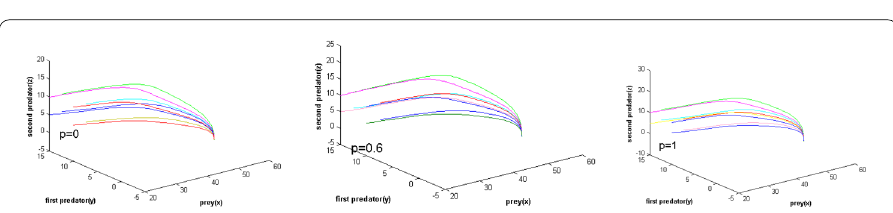
Figure 5 The model system (3.4) reaches the stable axial equilibrium point e 1 ( k ,0,0) for different values of the parameter p when numerical simulation is initiated from different initial points under the choice of model parameter values given in Table